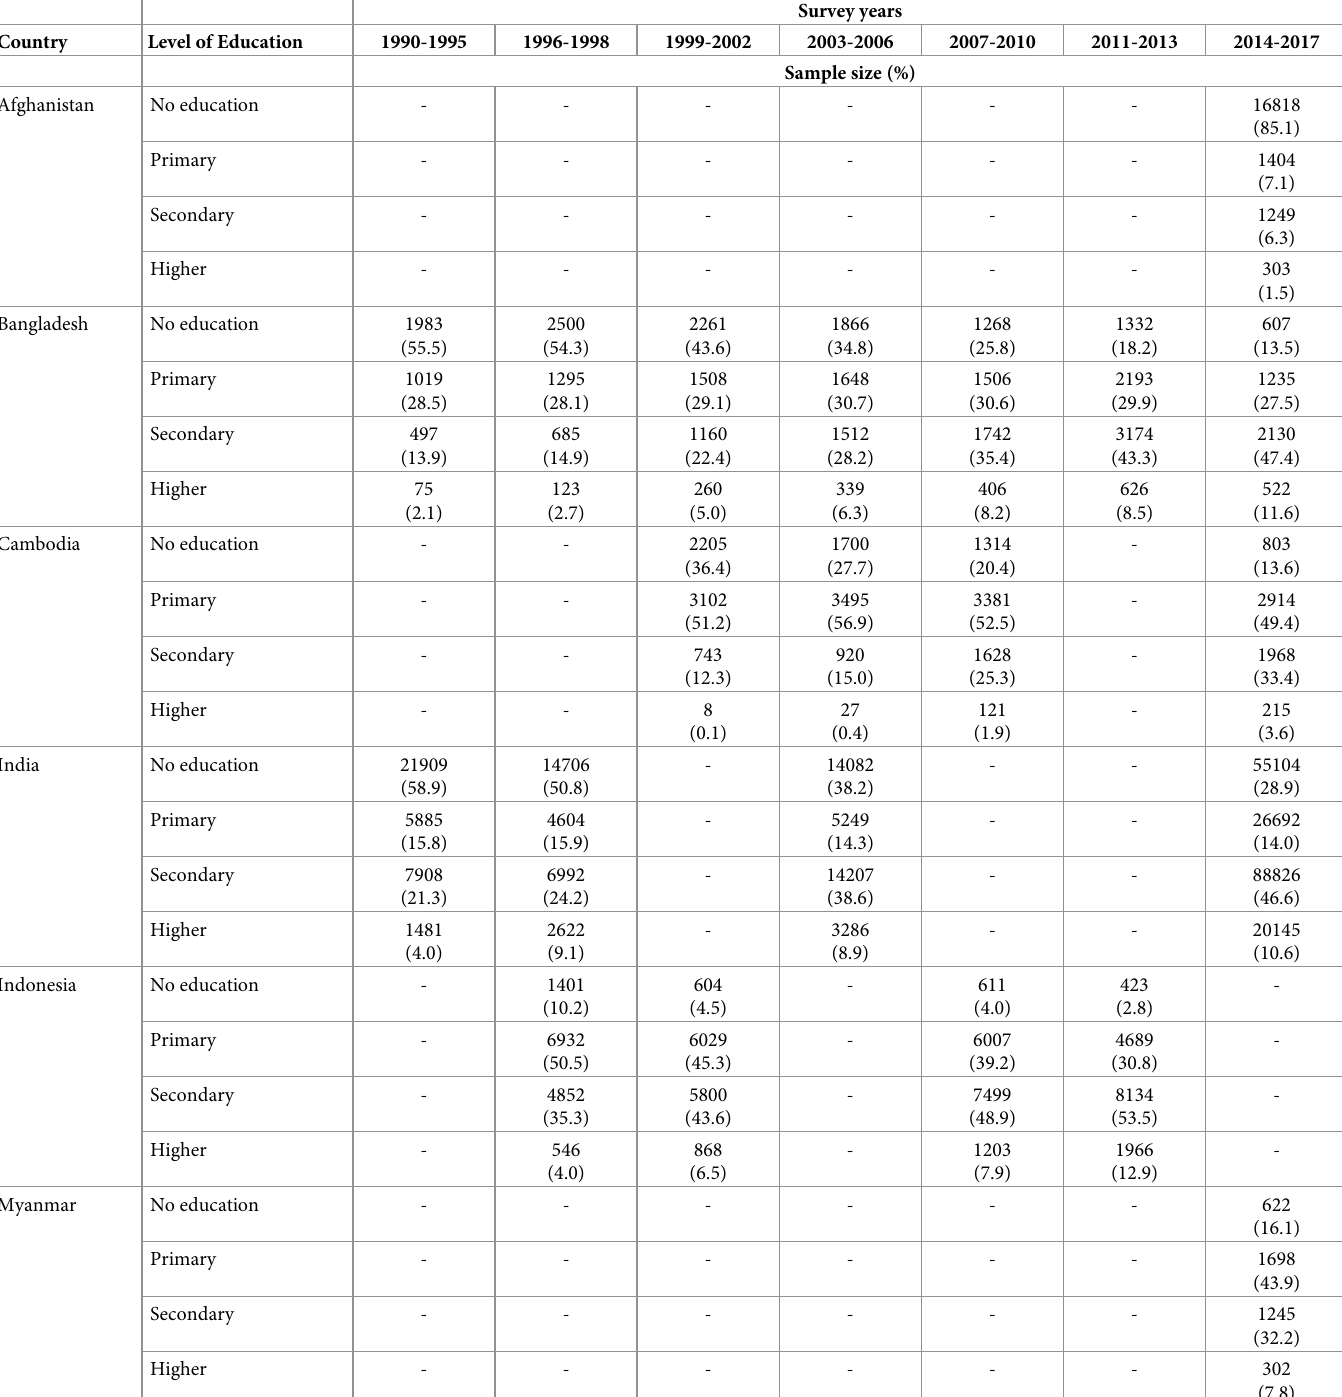
Table 1. Distribution of women’s level of education over 30 surveys across 10 selected countries the SSEA